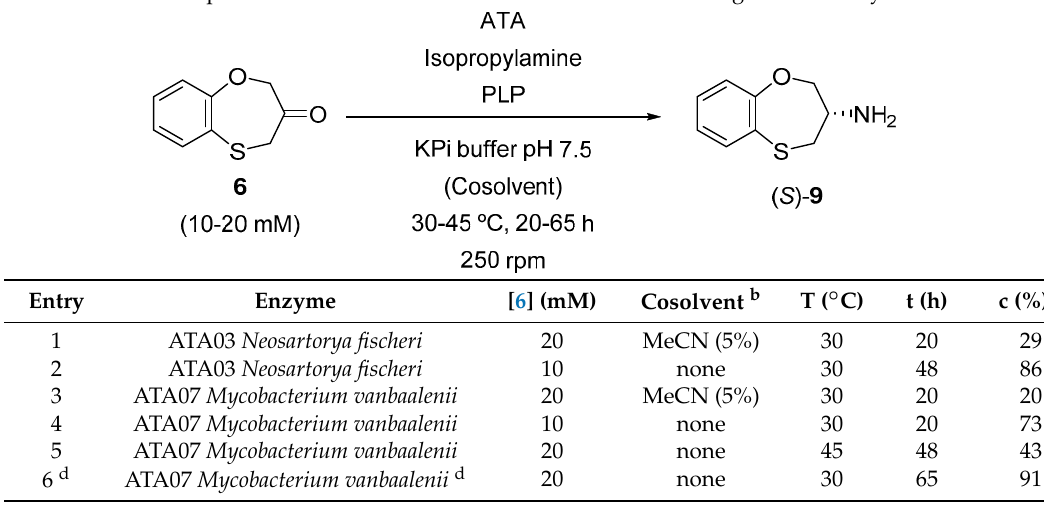
Table 3. Optimisation of the biotransamination of ketone 6 using selected enzymes a .